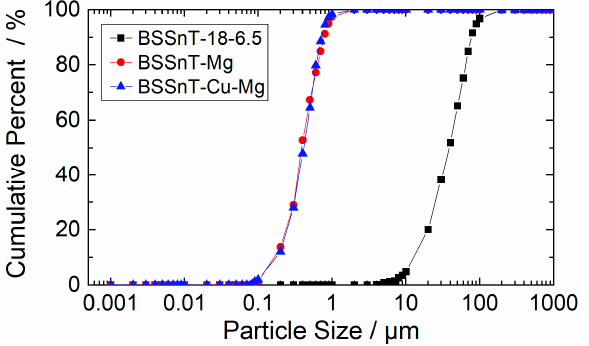
Figure 3. Grain size distribution of BSSnT-18-6.5, BSSnT-Mg and BSSnT-Cu-Mg.